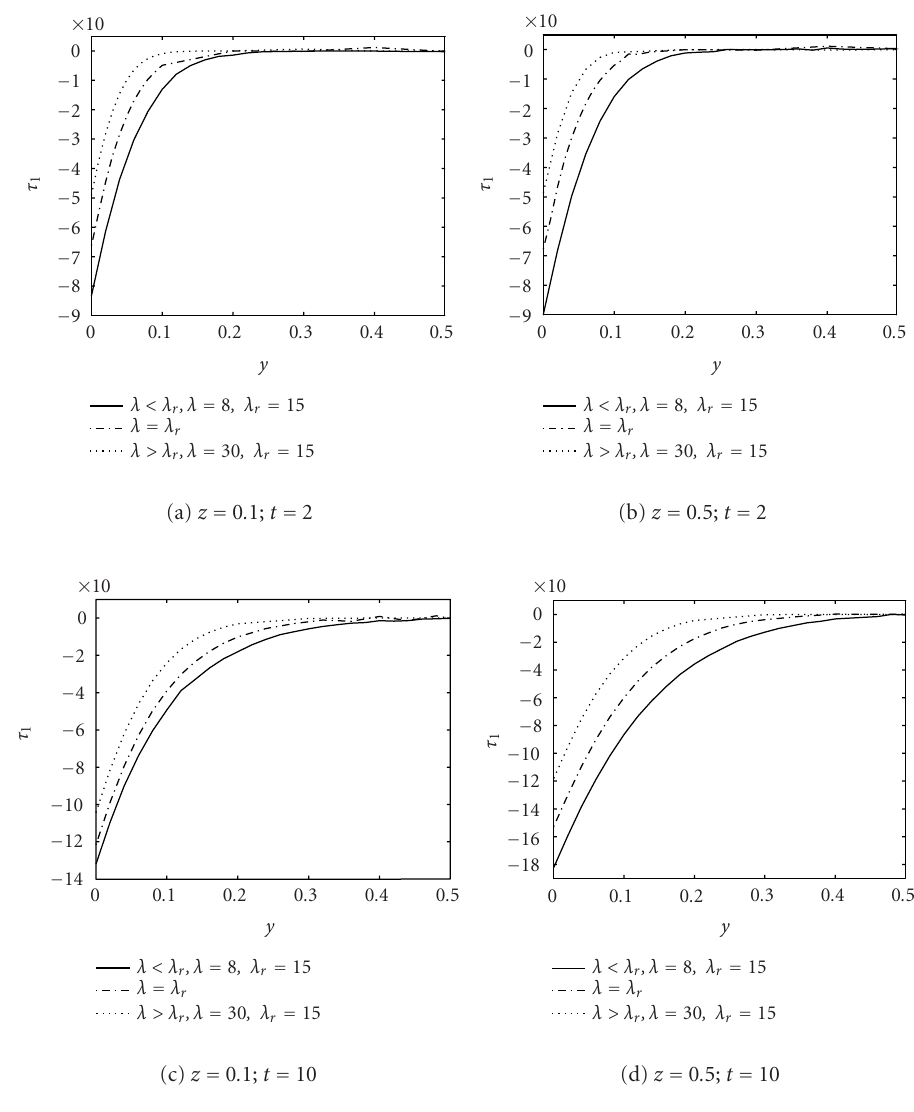
Figure 5.3. Tangential stress τ 1 corresponding to λ < λ r , λ = λ r , and λ > λ r , for A = 1 . 0, ν = 0 . 0011746, for z = 0 . 1 and z = 0 . 5cm, and t = 2 and 10s, respectively.